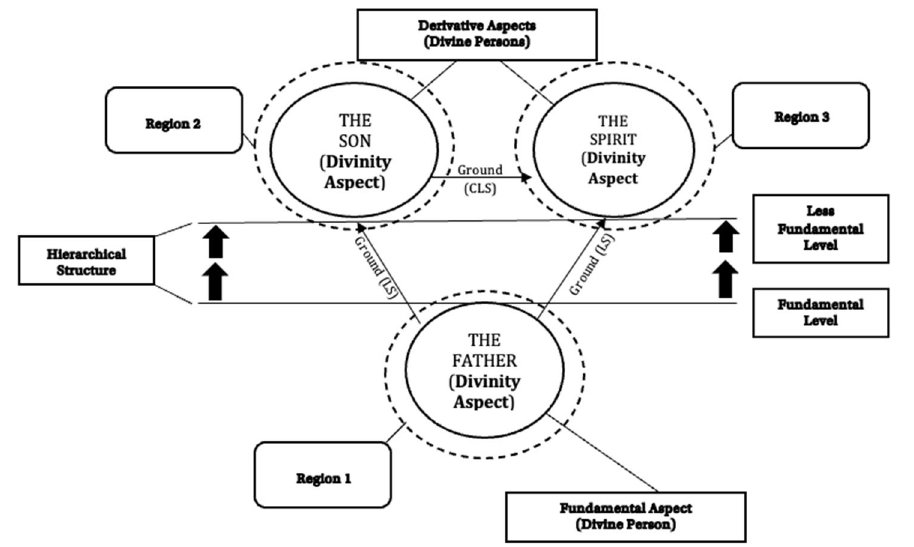
Figure 10. Trinitarian Fundamentality Structure.